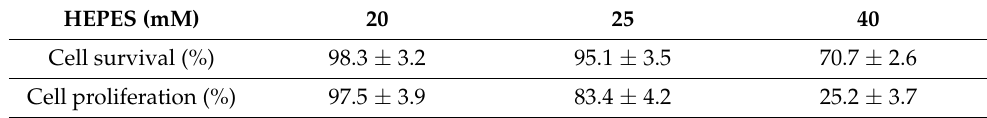
Table 1. Cell survival and proliferation rates in dependence on HEPES concentration. Percentage cell survival and proliferation of huMPCs cultured in EUs in the presence of the indicated HEPES concentrations with respect to huMPCs cultured in parallel in plates in standard medium conditions. HEPES (mM)